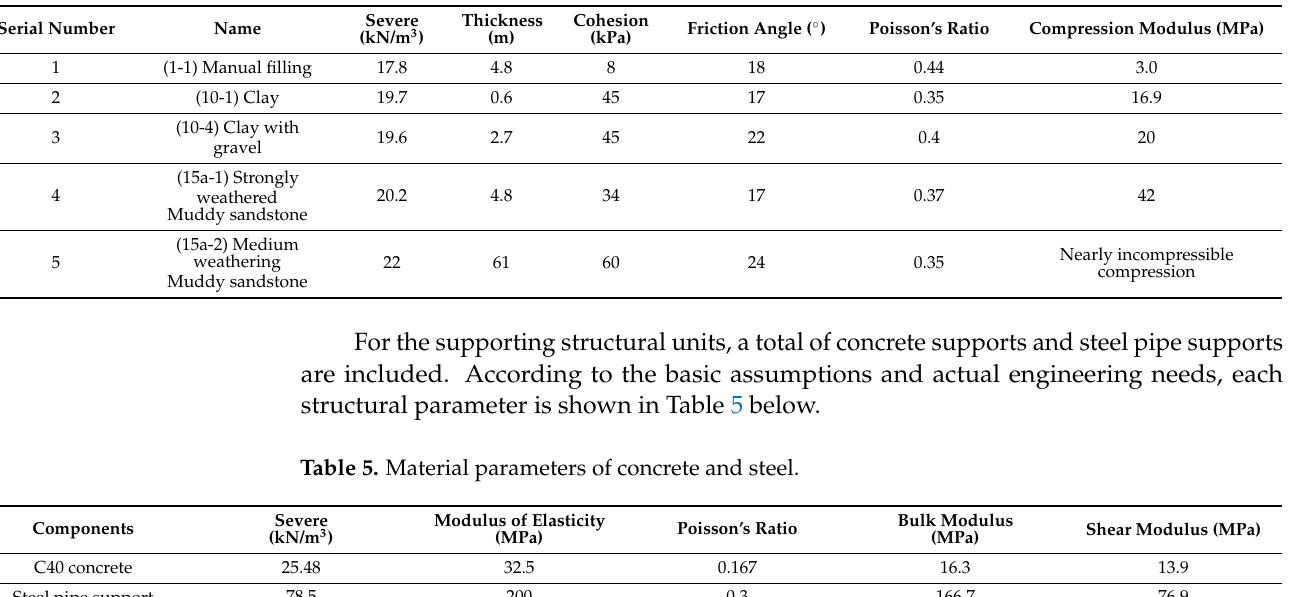
Table 4. The soil mechanical parameters.